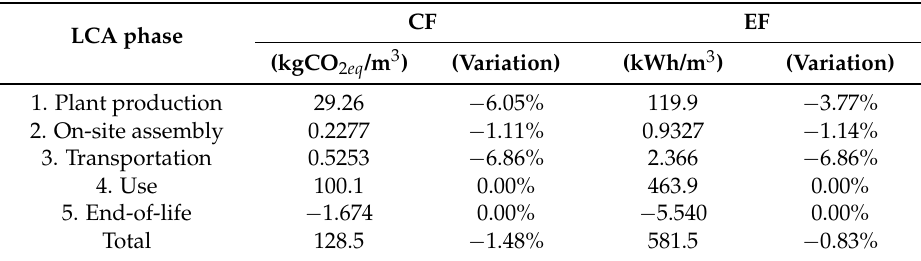
Table 8. Carbon and energy footprint for a reference building (10,000 m 2 ) in case of foundations without pillars. The variation is shown with respect to the reference scenario (with pillars).